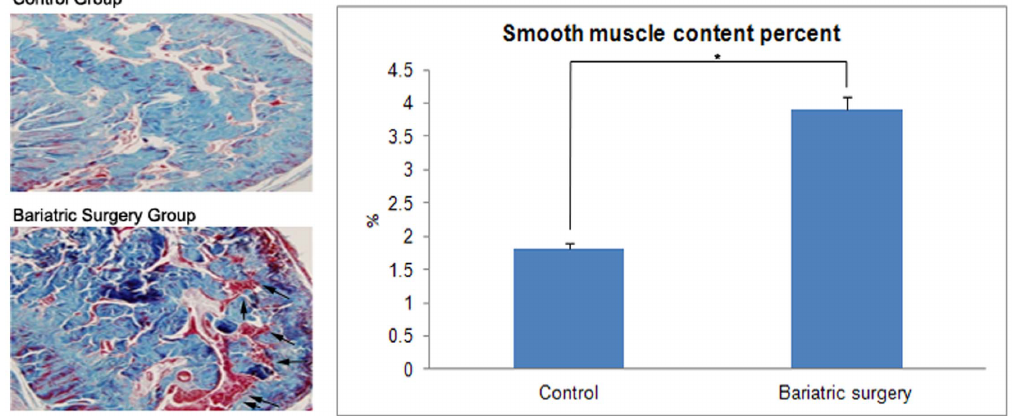
Figure 4. Histological analysis and smooth muscle/collagen fiber ratio between the control and bariatric surgery groups. The muscle fibers stained with red color were marked with an arrow. (Magnification 6 100, *: p=0.025).